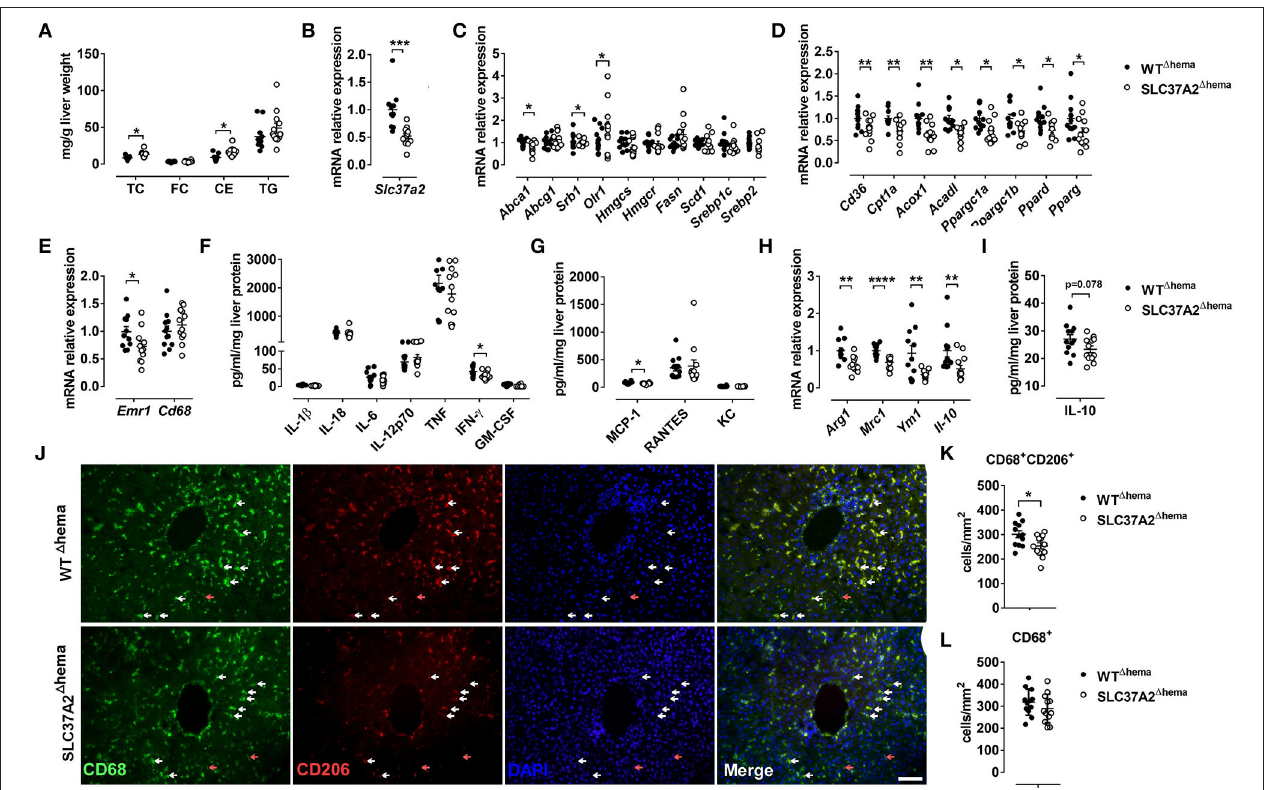
FIGURE 2 | Hematopoietic cell-specific SLC37A2 deletion increases liver cholesterol ester and reduces hepatic macrophage activation in WD-fed LDLrKO mice. Irradiated Ldlr − / − mice transplanted with WT or SLC37A2KO bone marrow were fed a high-fat western diet for 16 wks. (A) Fasting (4h) total cholesterol (TC), free cholesterol (FC), cholesterol ester (CE), and triglyceride (TG) concentrations in the liver were measured by enzymatic assays ( n = 12 per genotype). (B) Slc37a2 transcript expression in liver ( n = 12 per genotype). (C) Relative transcript levels for cholesterol efflux, cholesterol uptake, cholesterol synthesis, fatty acid synthesis, and transcriptional regulators controlling these pathways in the liver ( n = 12 per genotype). (D) Relative transcript levels for genes encoding key enzymes in fatty acid uptake, β -oxidation, and transcriptional regulators controlling these pathways in the liver ( n = 12 per genotype). (E) Relative transcript levels for genes encoding macrophage markers in the liver ( n = 12 per genotype). (F,G) Liver cytokine and chemokine protein concentrations ( n = 12 per genotype). (H) Relative transcript levels for genes encoding macrophage anti-inflammatory markers in the liver ( n = 12 per genotype). (I) Liver IL-10 protein concentrations ( n = 12 per genotype). (J) Representative images of CD68 and CD206 double-stained liver tissues. White and red arrowheads indicate representative CD68 + CD206 + and CD68 + CD206 − cells, respectively. Scale bar = 100 µ m. (K) Quantification of CD68 + CD206 + cell number in liver tissue ( n = 12 per genotype). (L) Quantification of CD68 + cell number in liver tissue ( n = 12 per genotype). Data are expressed as mean ± SEM. * P < 0.05, ** P < 0.01, *** P < 0.001, **** P < 0.0001, unpaired, two-tailed Student’s t